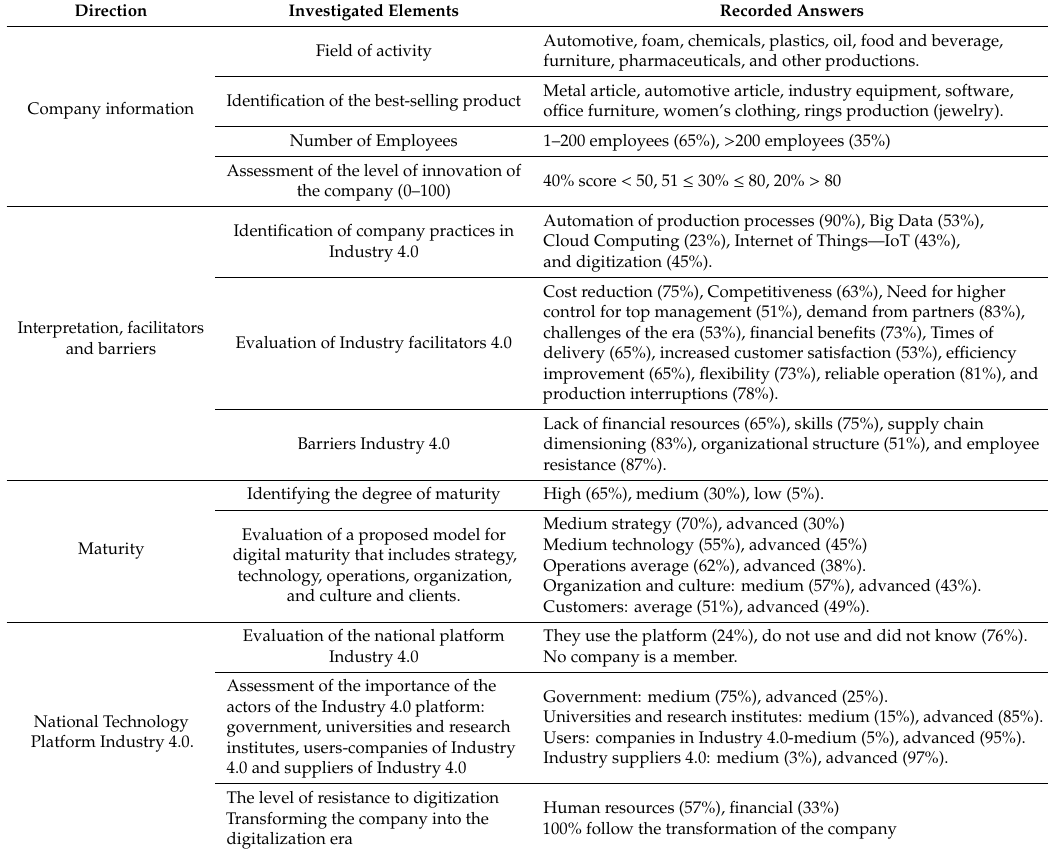
Table 5. Sustainable development and Industry